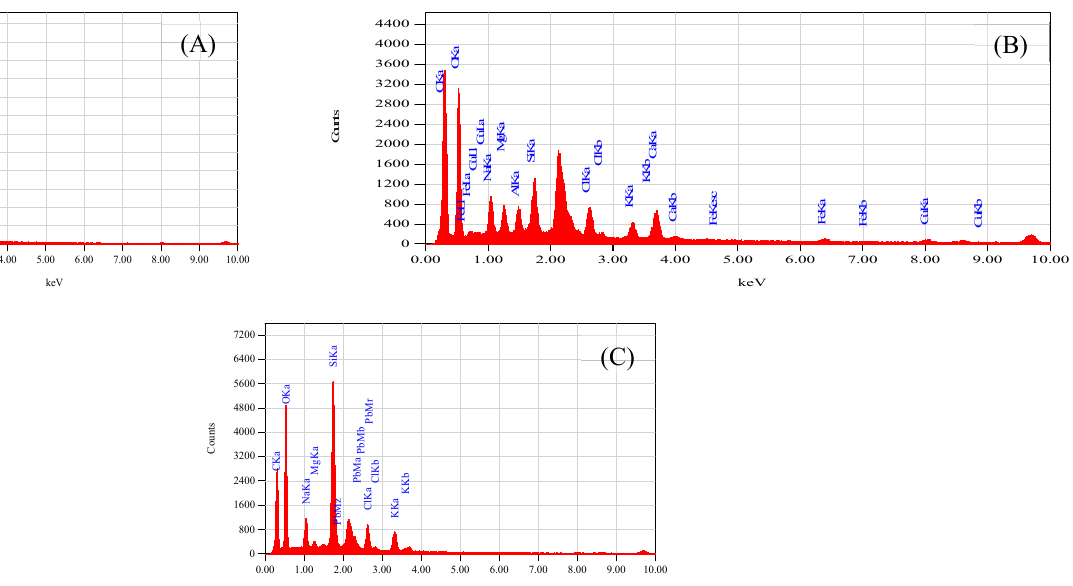
Figure 2. ( A ) Represents EDS spectra of S. oleracea plant “a”, ( B ) represents of plant “b”, and ( C ) represents of plant “c”.